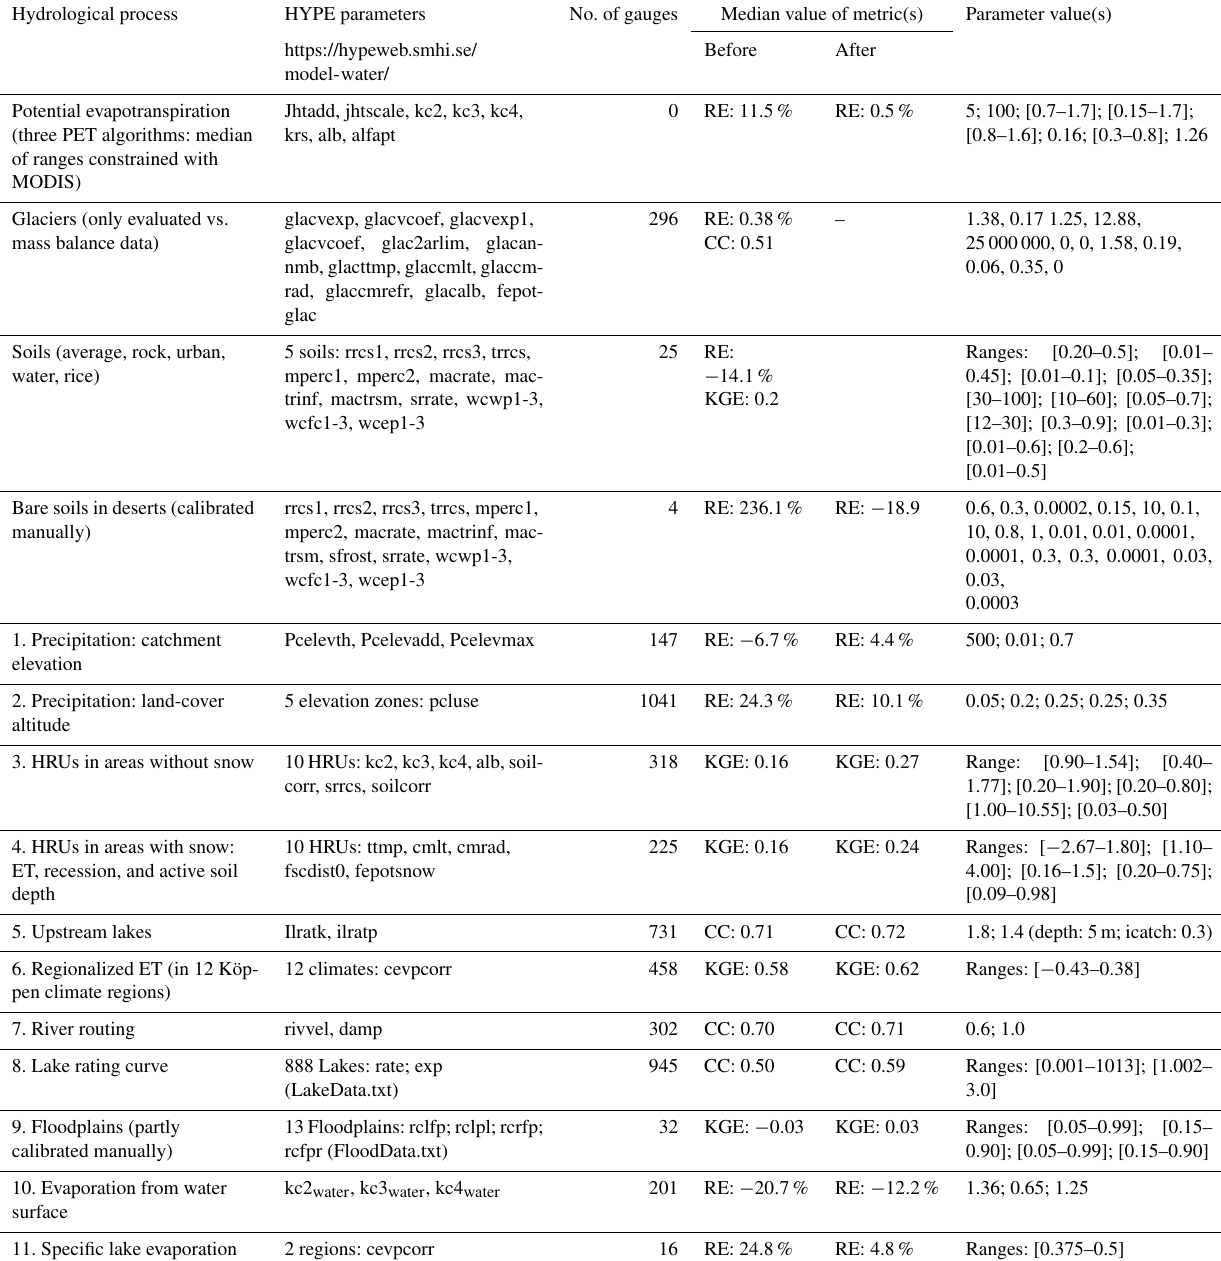
Table A1. Metrics and parameter values from the stepwise parameter estimation globally. Parameter names and values are given in the same order of appearance (columns 2 and